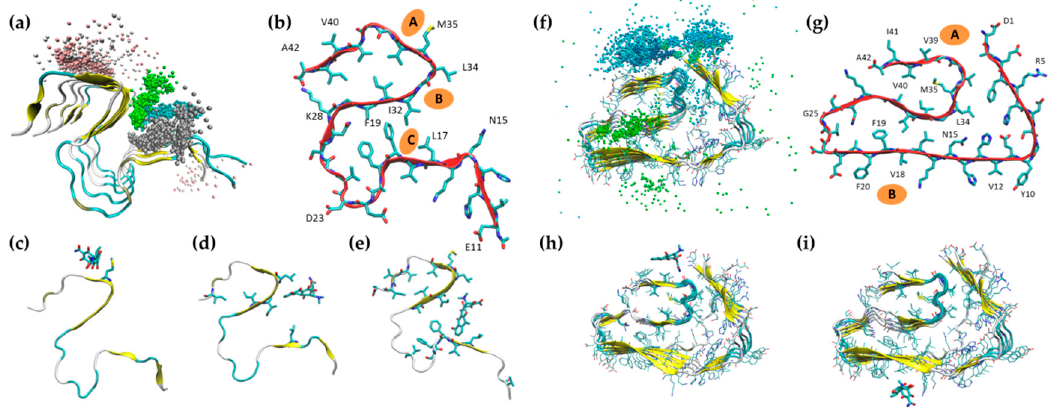
Figure 5. Doxycycline binding sites on A β 42 fibrils. Superposition of doxycycline coordinates (center of mass) during the MD simulations (excluding the first 200 ns) in the presence of the two polymorphs of A β 42 fibrils (2MXU, ( a ); 5OQV, ( f ).) Panels ( b) and ( g) show the main interaction sites. When simulated with the 2MXU structure, doxycycline stably bound to the side chain of M35 ( c ), within the groove formed by I32 and L34 ( d ) and within the groove formed by F19 and L17 ( e ). In the simulations with the 5OQV structure, doxycycline stably interacted with the hydrophobic groove formed by V39 and I41 ( h ), as well as with the groove formed by F20 and V18 ( i ).